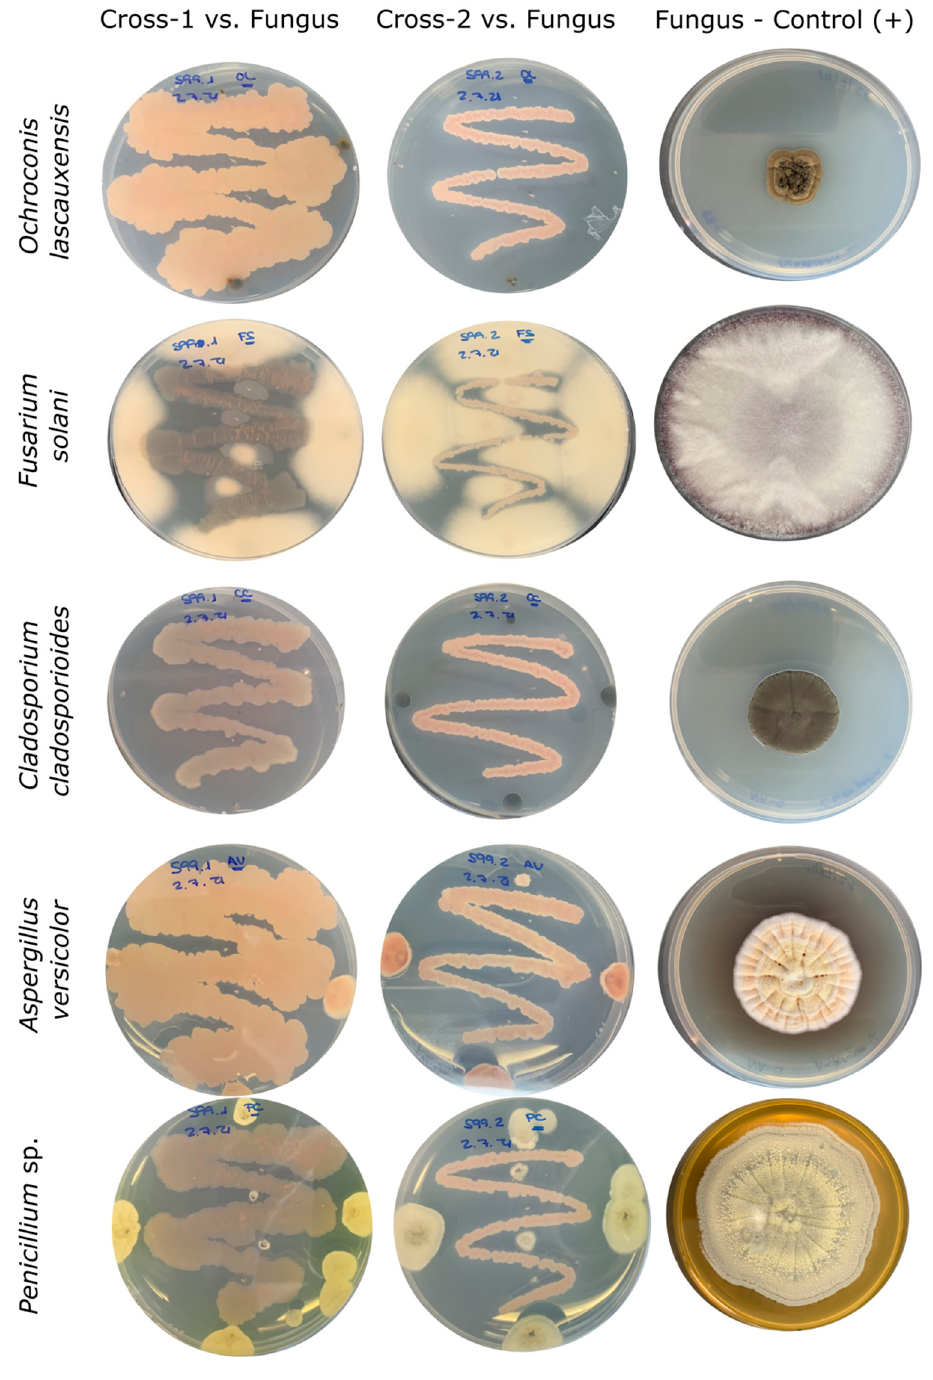
Figure 3. Fungal inhibition assay after 28 days of incubation. The bioactivity of strains Cross-1 ( left column) and Cross-2 ( center column) were evaluated in comparison with the normal growth of fungus ( right column). Bacteria were cultured 24 h before the inoculation of fungal strains. The fungi were picked with a wood-stick and positioned separately in four external points of the plate and between the traced bacteria.